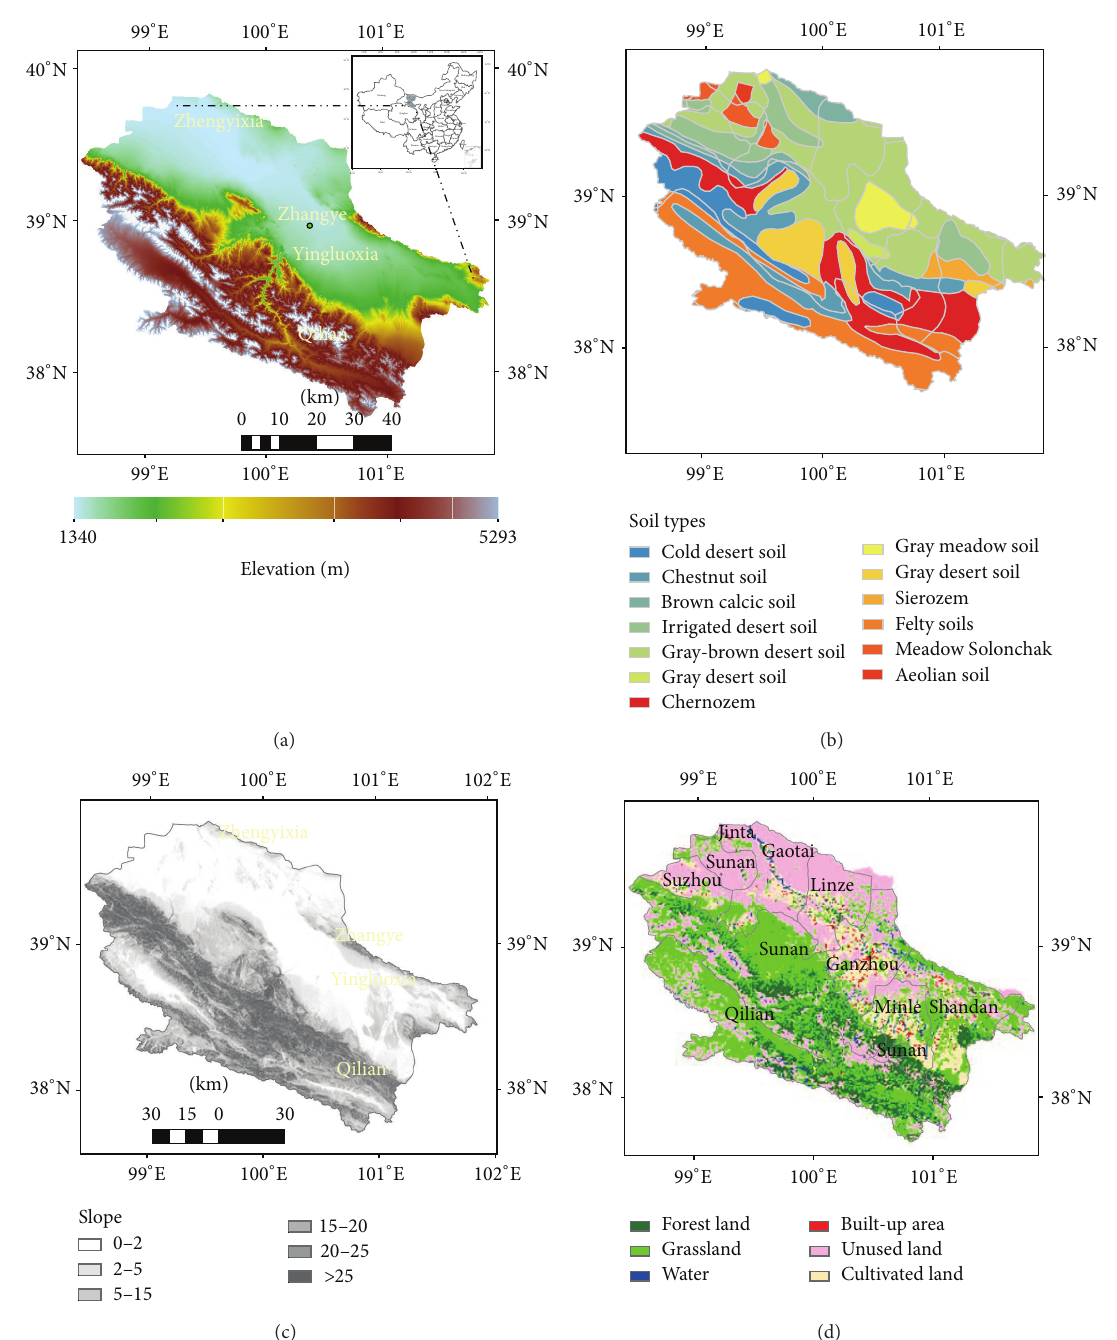
Figure 1: The upper and middle Heihe River Basin: (a) digital elevation model, (b) soil type, (c) slope, and (d) land use in 2010.